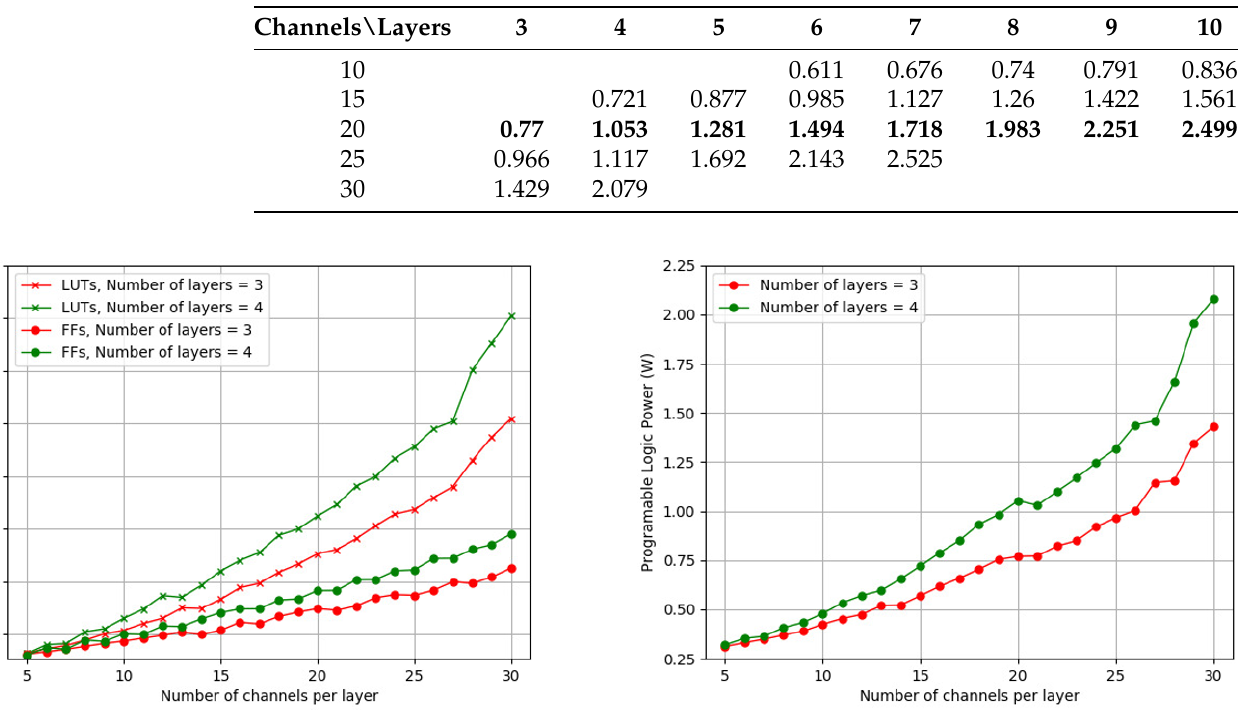
Table 4. Cost estimation charts for power consumption.